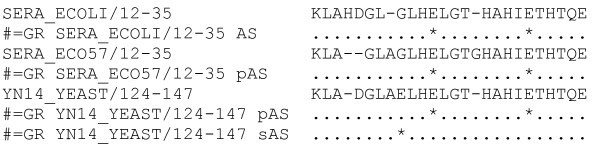
Sample multiple sequence alignment with active site markup in Stockholm format as used in the Pfam flatfiles. AS indicates an experimental active site, pAS indicates a Pfam predicted active site and sAS indicates a UniProtKB predicted active site.